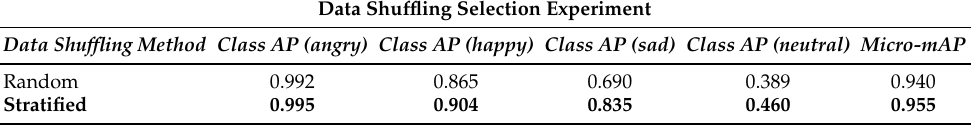
Table 5. Comparison between random and stratified data selection methods for LSTM and MLP with JRA and